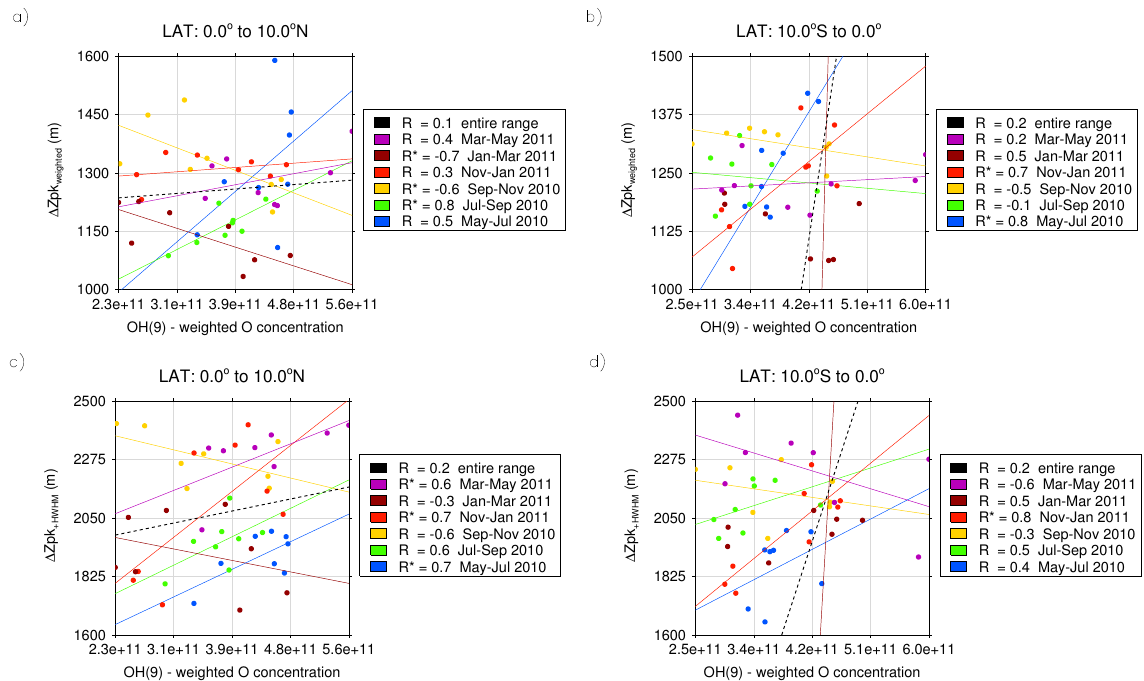
Figure 12. Correlation between relative night-time VER shifts and O concentrations from SABER observations in analogy with Fig. 9. vertical OH(9;5) profile shifts than we would receive